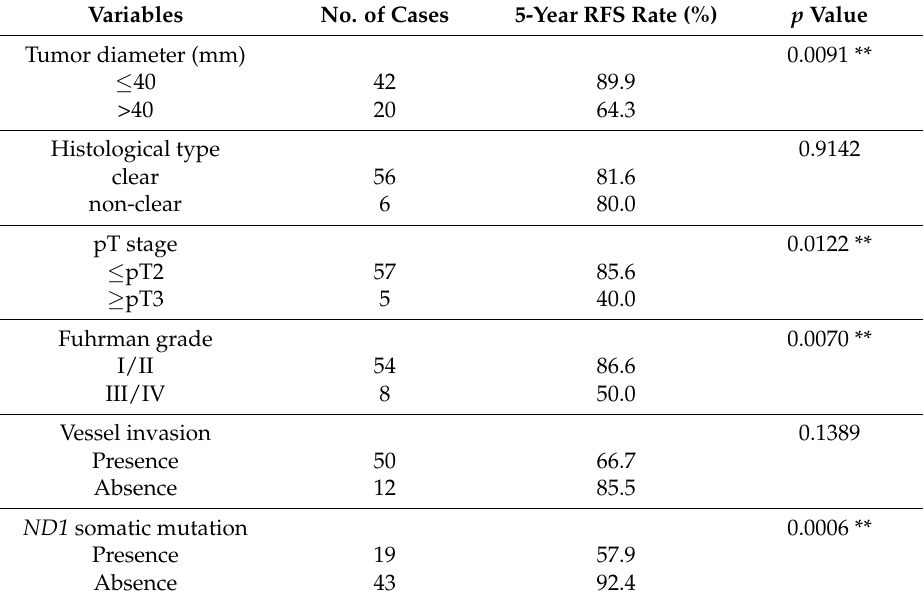
Figure 2. Kaplan–Meier curve for the 5-year RFS ( a ) and CSS ( b ) of a total of 62 patients included in this study.